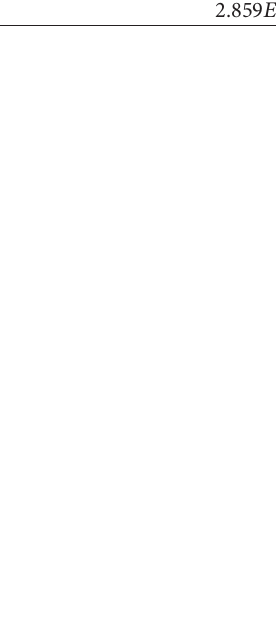
Table 1: Torsion, warping constants, and primary warping function at the interface lines of the stiffening beam of Example 1. ℎ 𝐼 4 ) 𝑏 (cm) 𝑡 (cm